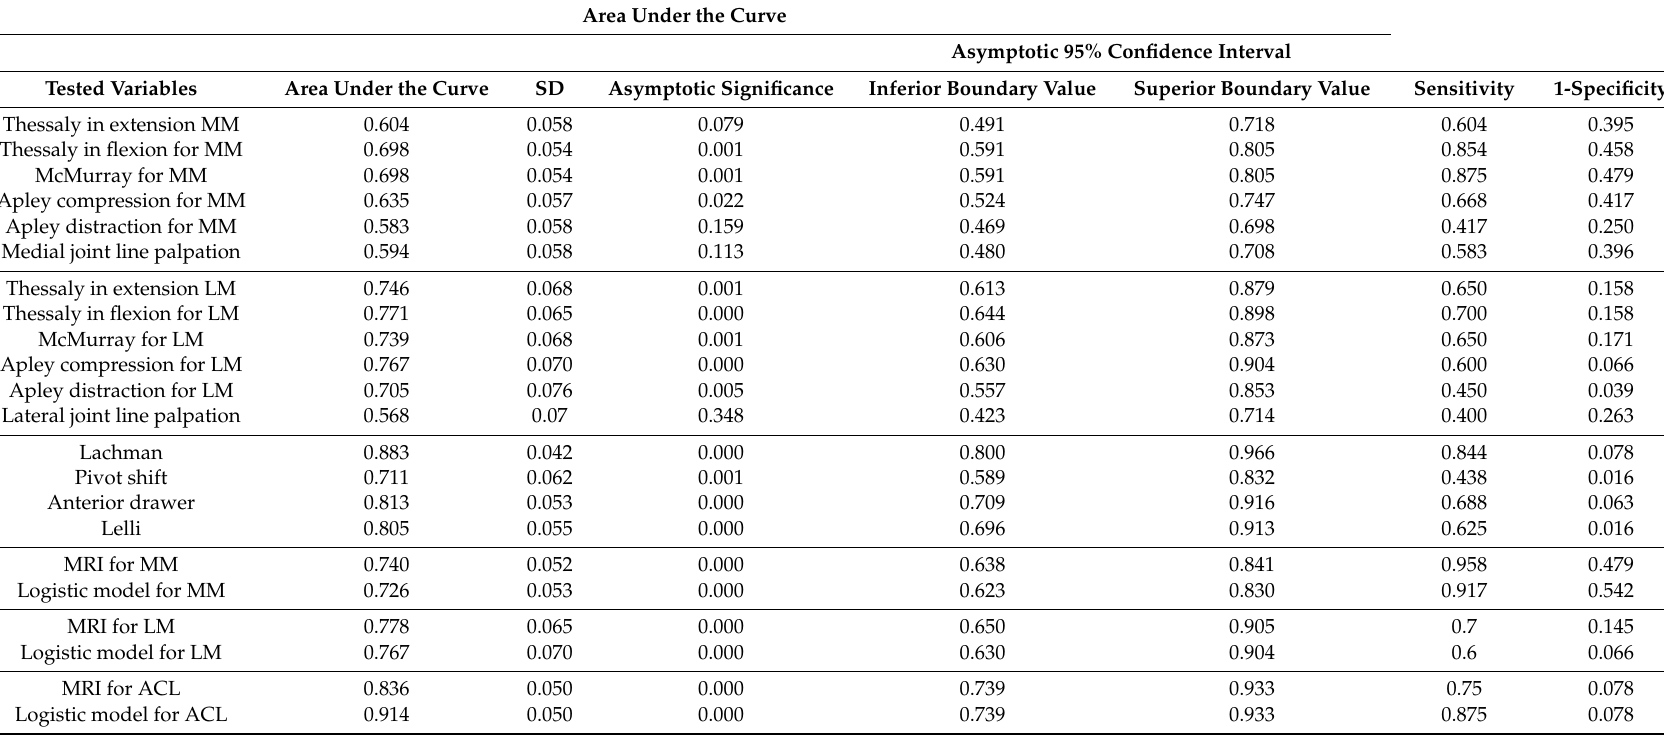
Table 2. Relation of specificity to sensitivity for physical examinations and MRI for MM, LM and ACL. Area Under the